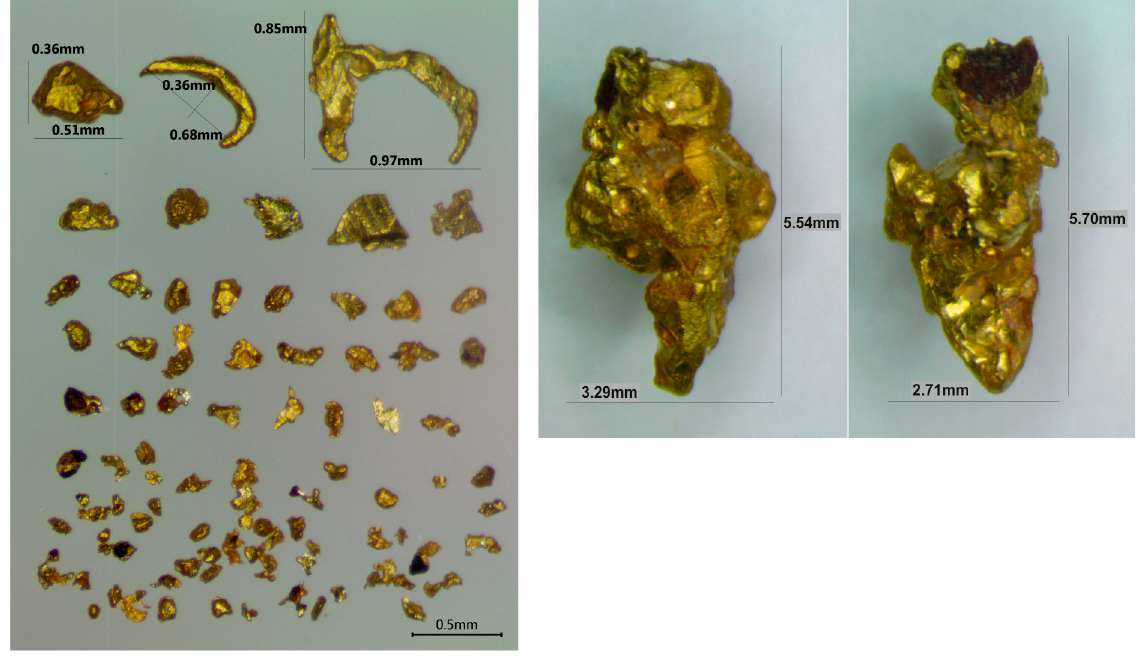
Figure 6. Granulometry of supergene gold.